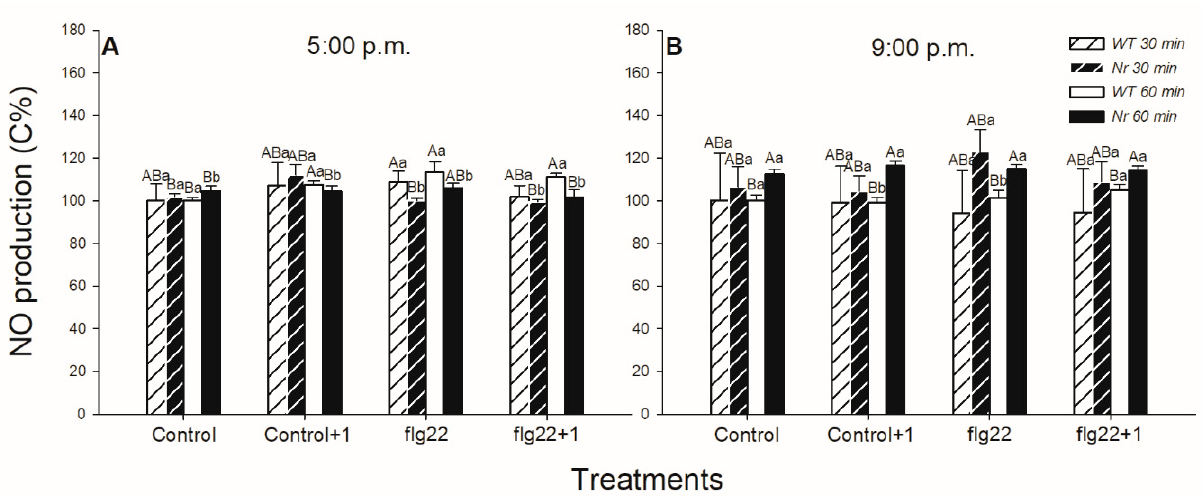
Figure 2. Changes in the nitric oxide (NO) production in leaves of intact wild type (WT; white columns) and ethylene- insensitive Never ripe ( Nr ; black columns) tomato plants treated foliar using a squirrel-hair brush with 5 μ g mL − 1 of flagellin (flg22) in the late afternoon under light (at 5:00 p.m.) ( A ) or at night under darkness (at 9:00 p.m.) ( B ). Measurements were carried out 30 and 60 min after treatments. Leaf discs prepared immediately from the whole leaves from the different leaf levels and genotypes were incubated in DAF-FM DA fluorescent dye; then, fluorescence intensities were determined by microscope. Means ± SE, n = 3. Means were analysed by two-way ANOVA; significant differences among the data were analysed by Duncan’s test. Mean values significantly different at p < 0.05 are indicated by different letters, upper case letters indicate the effects of the treatment at the same time of day and lower case letters indicate the effects of daytime under the same treatment. (Control, treatment with sterile distilled water; Control+1, untreated distal leaf level to the control; flg22, treatment with 5 μ g mL − 1 of flagellin dissolved in sterile distilled water; flg22+1, untreated distal leaf level to the flg22-treated one).